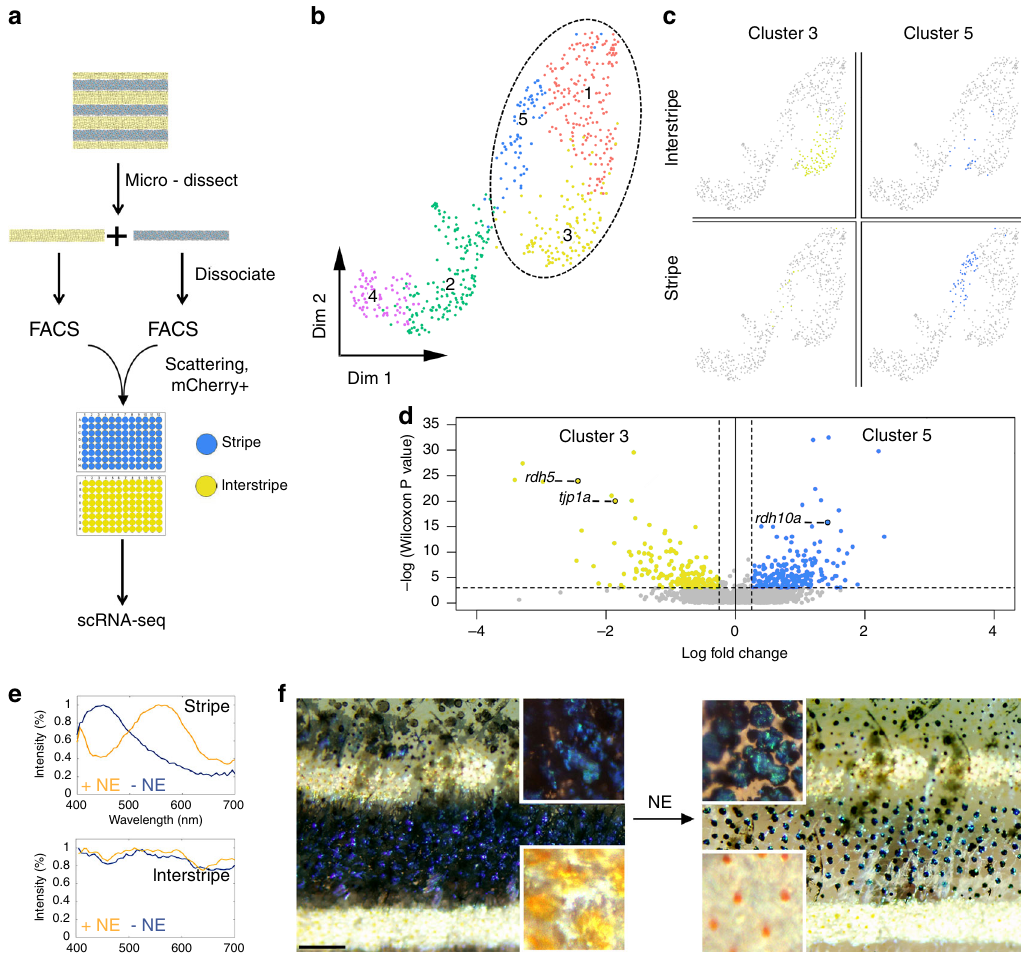
Fig. 5 Disordered- and ordered-crystal-containing iridophores exhibit distinct transcriptomic signatures and response to stimuli. a Experimental design of single-cell RNA-sequencing experiment. b Two-dimensional UMAP representation of the collected skin cell clusters (dashed ellipse marks iridophores). c Anatomical origin (stripe versus interstripe) of iridophores from clusters 5 (blue) and 3 (yellow). d A volcano representation of differentially expressed genes between clusters 5 (blue) and 3 (yellow), where 192 genes were upregulated in cluster 5 and 158 were upregulated in cluster 3. e , f The response of an adult zebra fi sh skin pattern to norepinephrine (NE) stimulation. e The optical response of individual iridophores from the stripe (upper panel) and interstripe (lower panel). In the stripe, the re fl ection peak of an ordered iridophore shifts from ~450 to ~570 nm upon NE treatment. In the interstripe, only minor changes in the re fl ection spectra occur in response to NE. n = 4 different fi sh ( f ) illustrates optical response from relaxed, untreated fi sh ( − NE) to the treated fi sh ( + NE). Note the differences between the blue stripe and the two- fl anking yellow interstripes and how this changed with NE treatment. Before treatment, a deep blue color for the stripe region and a golden-yellow color for the interstripe region is observed. After NE treatment, the contrast between the stripe and the interstripe is drastically reduced. This color change arises because NE causes pigment granules within the melanophores in the stripe to aggregate in the cell center and blue iridophore re fl ectance to shift from a dark-blue to green-yellow hue (see upper insets), while in the interstripe, NE causes the pigment granules within the xanthophores to aggregate and silvery iridophores to have only a minor color change (lower insets), n = 3 different fi sh. Scale bar, f 400 μ